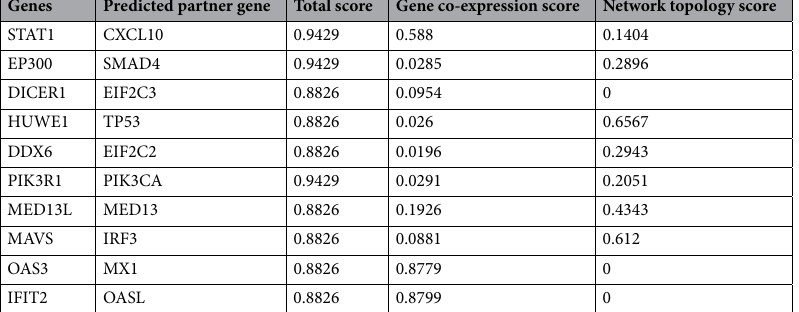
Table 2. Partner scores of the top 10 upregulated genes associated with ILA between the IL-1β and ILA-IL-1β groups analyzed by the FpClass tool.